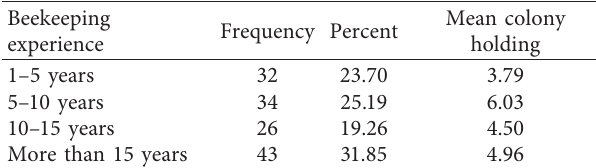
Table 3: Beekeeping experience of